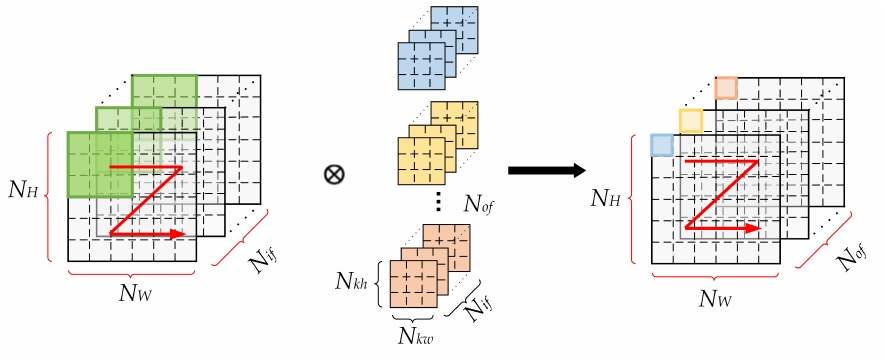
Figure 1. Standard convolutional